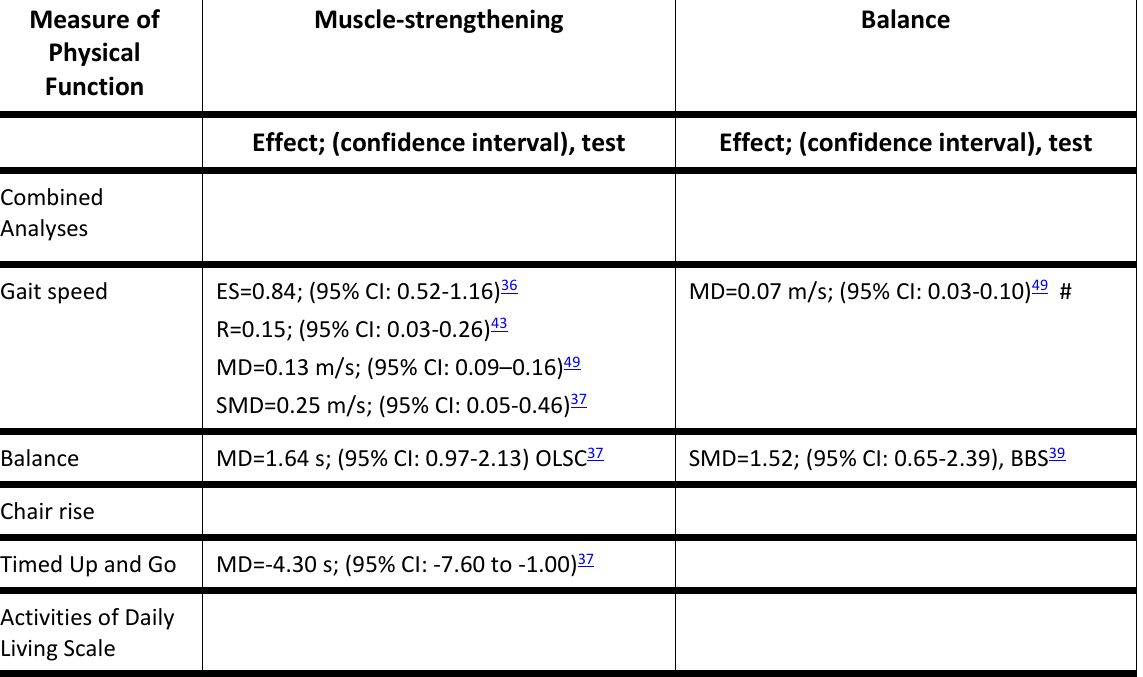
Table F9-1. Effects of Physical Activity from Meta-Analyses of RCTs of Aerobic, Muscle-Strengthening, Balance, and/or Multicomponent Physical Activity